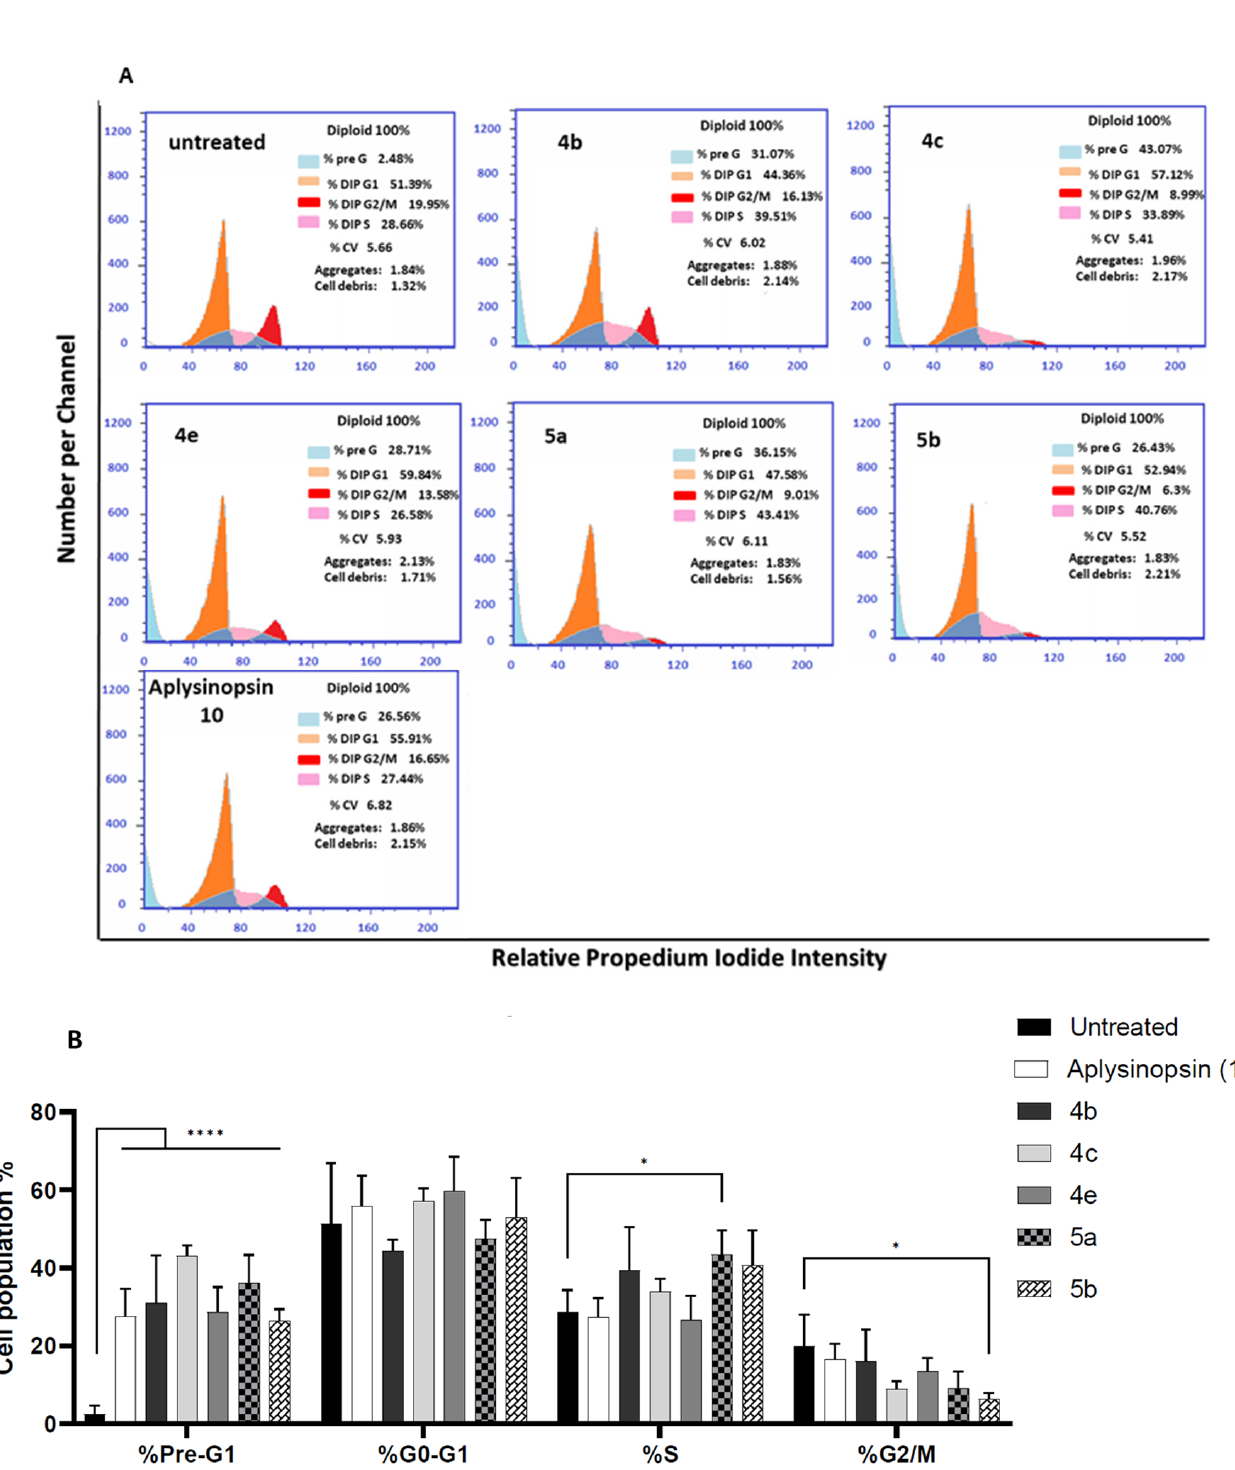
Figure 2. ( A ). Histograms of cell cycle phase distribution using PI staining for FACS analysis. ( B ). Percentages of cells accumulation in Pre-G1, G0-G1, S and G2/M cell cycle phases induced by analogs 4b , 4c , 4e , 5a , 5b, and aplysinopsin ( 10 ). Data are represented as the mean ± SD of three independent experiments. Statistical analysis was conducted using two-way ANOVA followed by Dunnett’s multiple comparison test; * p < 0.05, **** p < 0.0001 compared to the